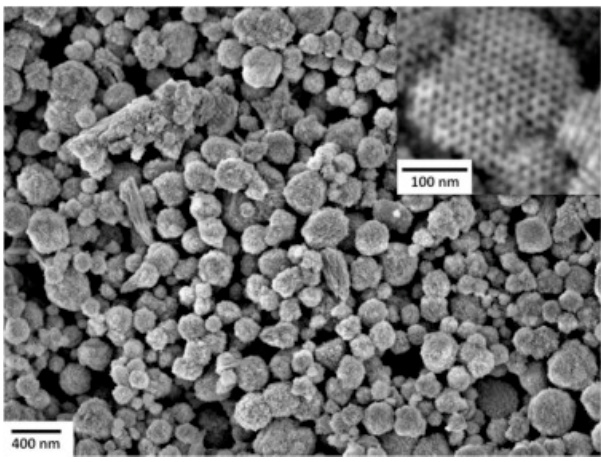
Figure 39. SEM of mesoporous In 2 O 3 . Inset is higher magnification. Reproduced with permission from [68].